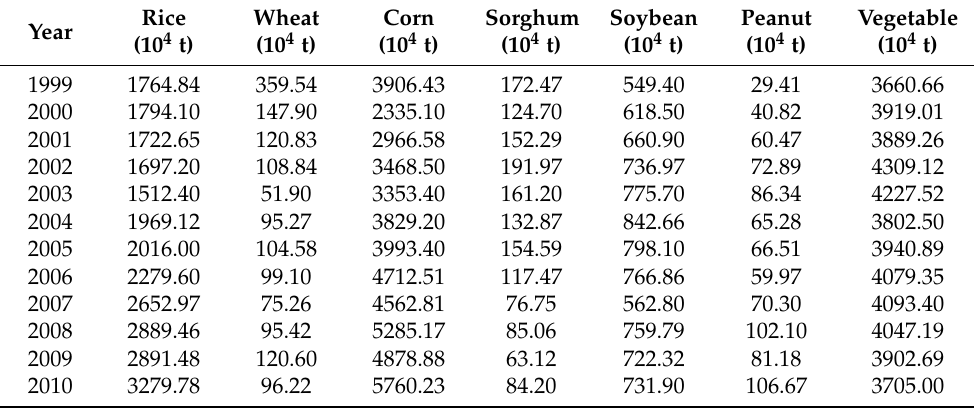
Table 2. Yield of different crops in three provinces of Northeast